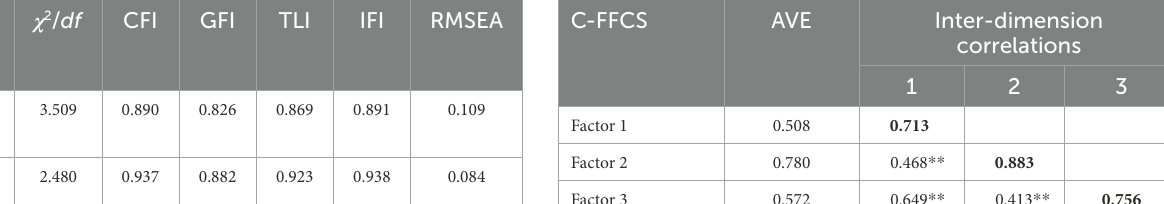
TABLE 4 Results of the confirmatory factor analysis of the C-FFCS ( N = 211). TABLE 5 Correlation coefficient and AVE ( N = 170).